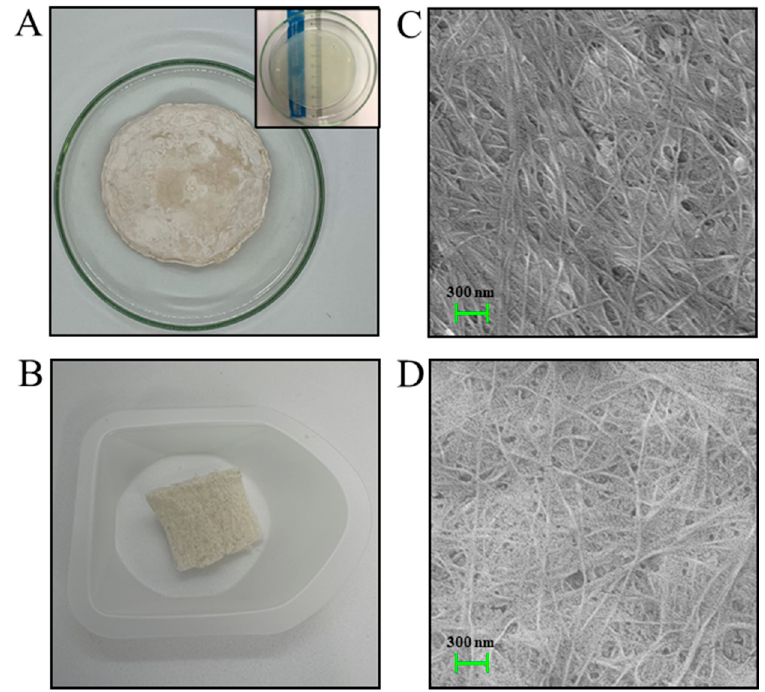
Figure 1. Macroscopic images of ( A ) BC and ( B ) BC TO ; inset represents wet BC pellicle. Scanning electron microscope (SEM) images of ( C ) BC and ( D ) BC TO (scale bar: 300 nm). electron microscope (SEM) images of ( C ) BC and ( D ) BC TO (scale bar: 300